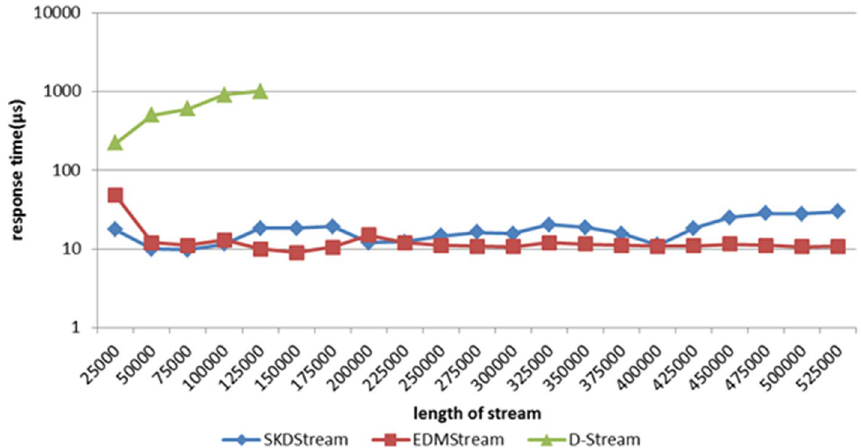
Fig. 14 Comparison of response time(CoverType). In the figure 14, the blue, red and green fold describe the response time ofSKDStream, EDMStream and D‑Stream respectively in the CoverType dataset